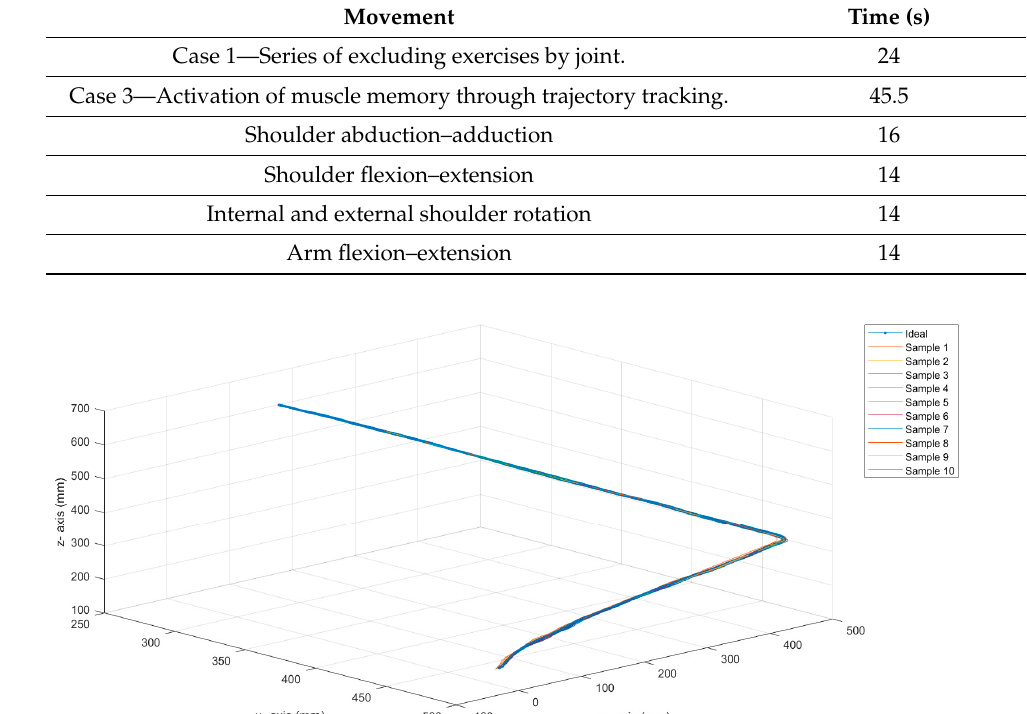
Table 5. Absolute error in trajectories of no-load